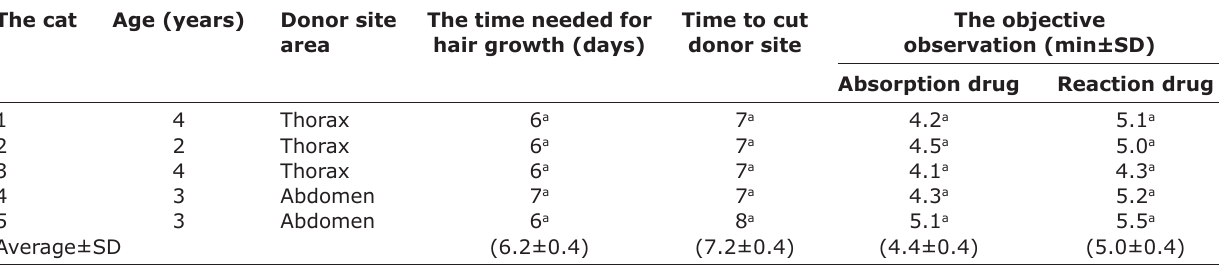
Table-3: Observation of hair growth, time to cut donor site, absorption, and reaction drug test. The